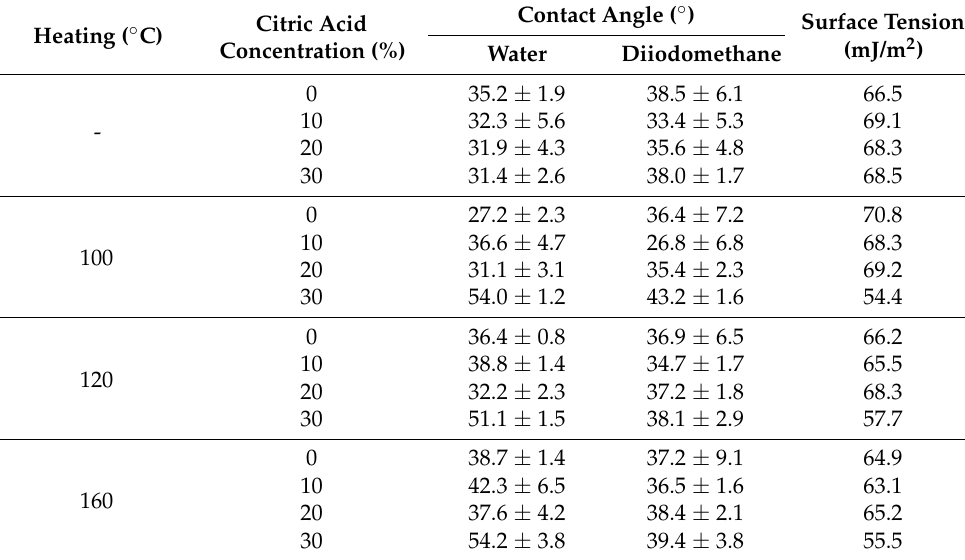
Table 1. The effect of heating at 100, 120, and 160 ◦ C for 10 min, citric acid addition at 0, 10, 20, and 30% concentrations on the contact angle measured with water and diiodomethane, and surface tension of CNC films plasticized with 15% glycerol. Contact Angle ( ◦ ) Surface Tension Citric Acid Heating ( ◦ C) (mJ/m 2 )Water Diiodomethane Concentration (%) 0 35.2 ± -